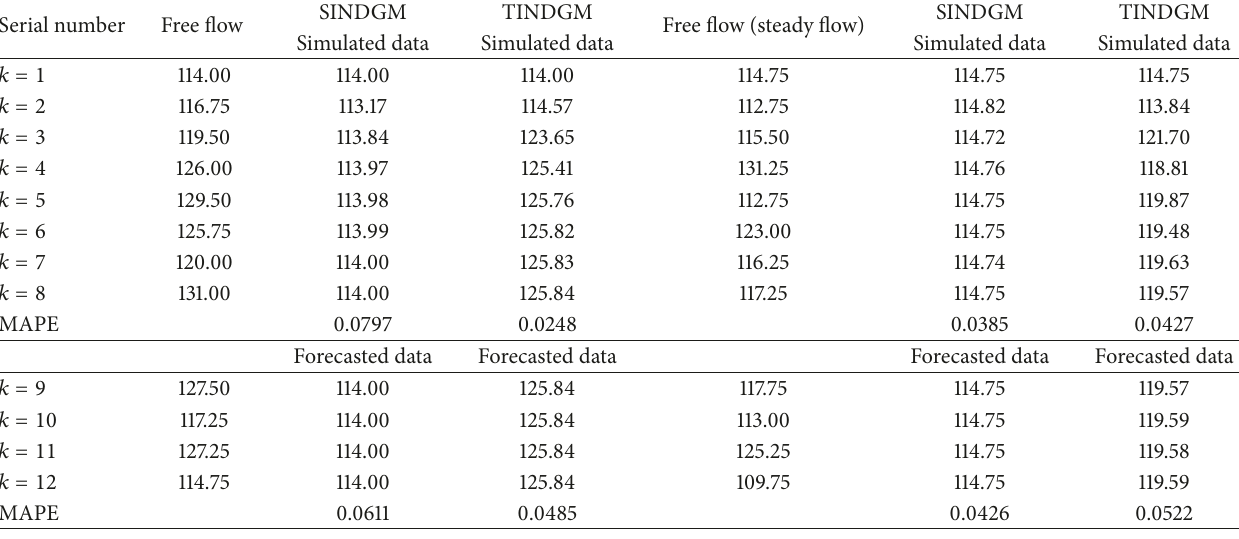
Table 2: Comparison of simulative and predictive results between the SINDGM and TINDGM for August